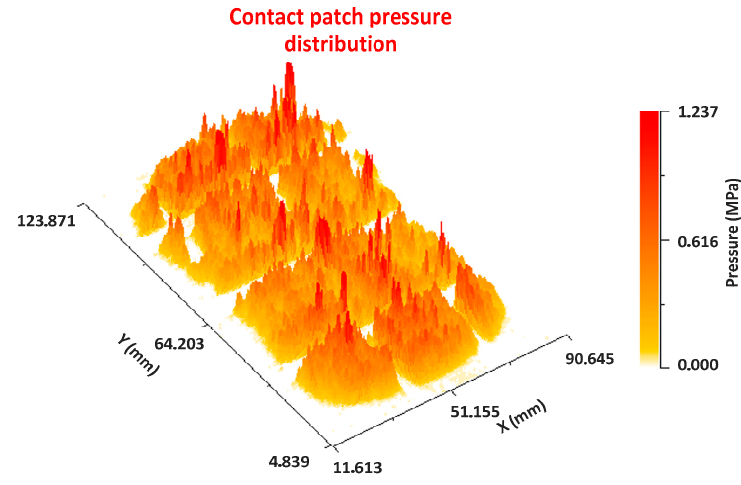
Figure 29. Contact patch pressure distribution—Abrasion.